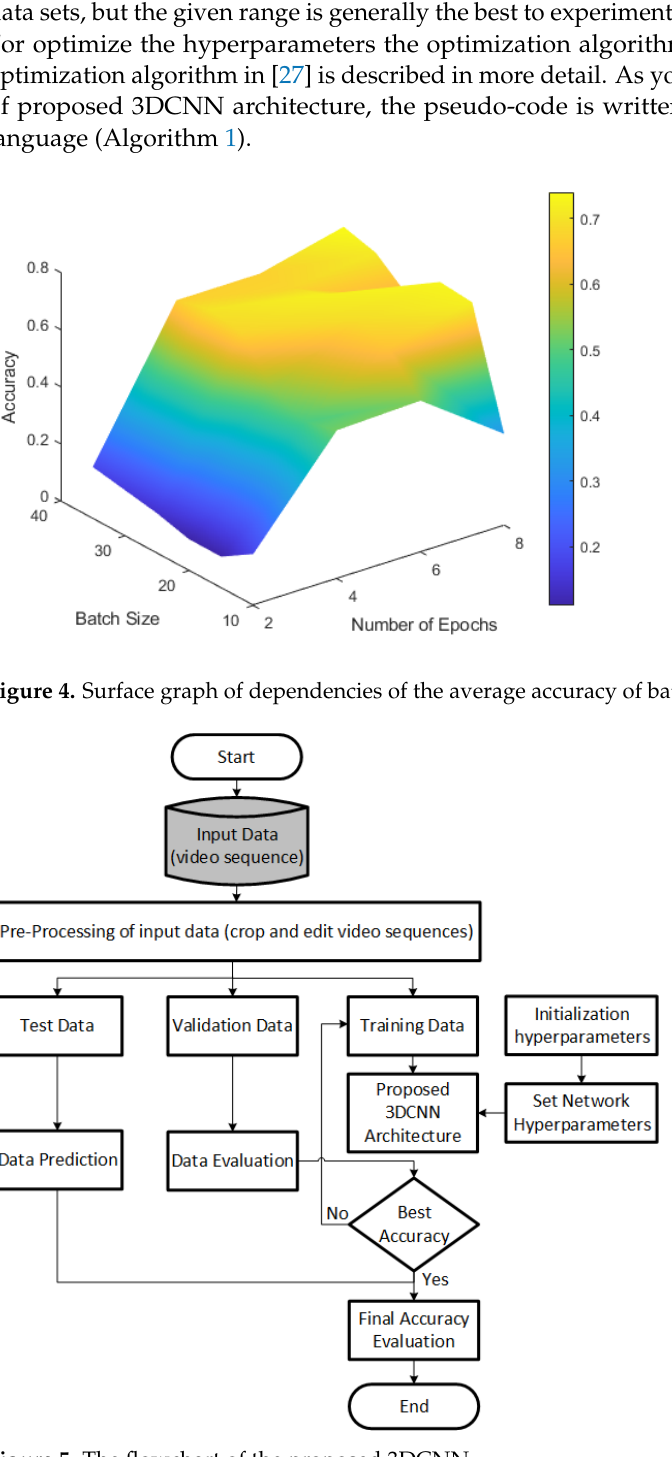
Figure 5. The flowchart of the proposed